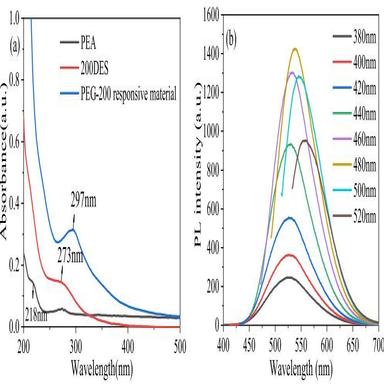
(a) UV–Vis spectrum of CO2-responsive phase transfer materials (PEG-200); (b) Fluorescence emission spectra of CO2-responsive phase transfer materials (PEG-200) under different excitation wavelength from 380 to 520 nm.